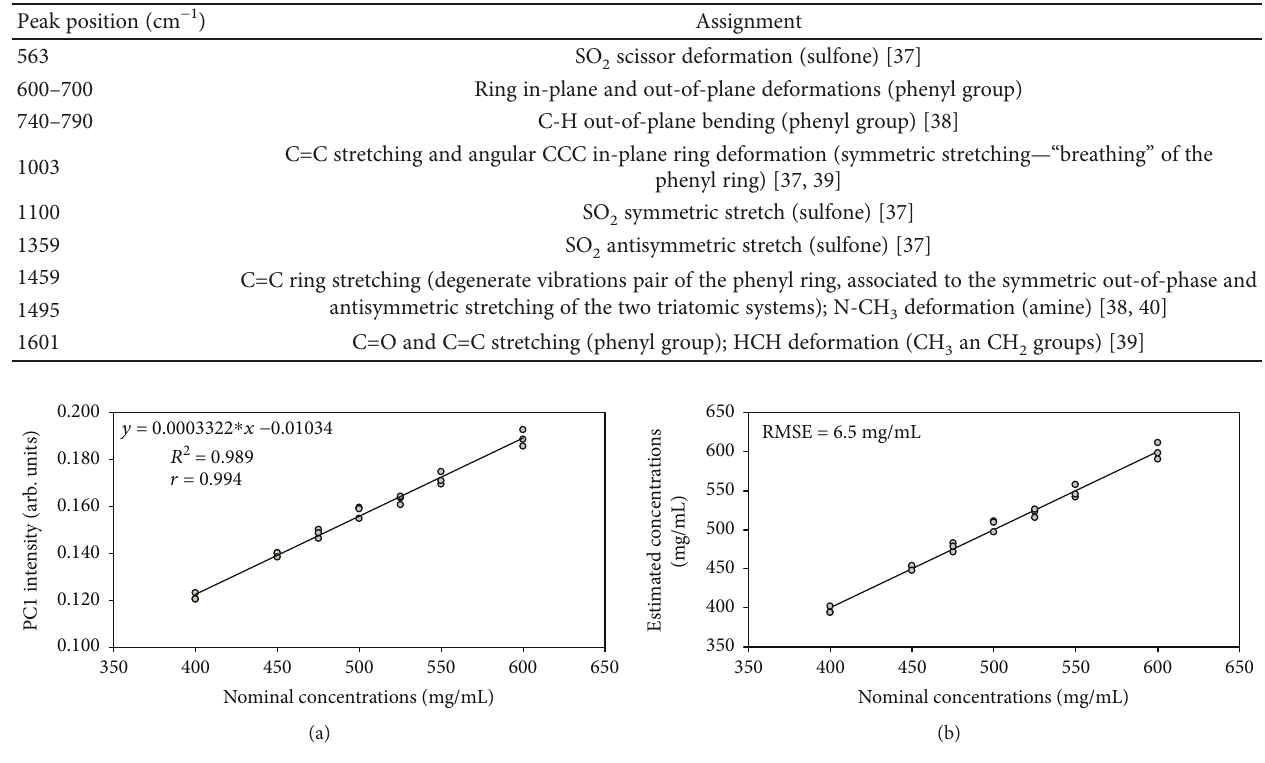
Figure 4: (a) Plot of the nominal concentrations of the seven dilutions of dipyrone, in the range from 400 to 600mg/mL (80 to 120%) versus the intensities of PC1, showing high correlation of the PCR model ( r = 0 994 ). (b) Plot of the model-estimated concentrations versus the nominal concentrations and estimated RMSE = 6 5 mg/mL